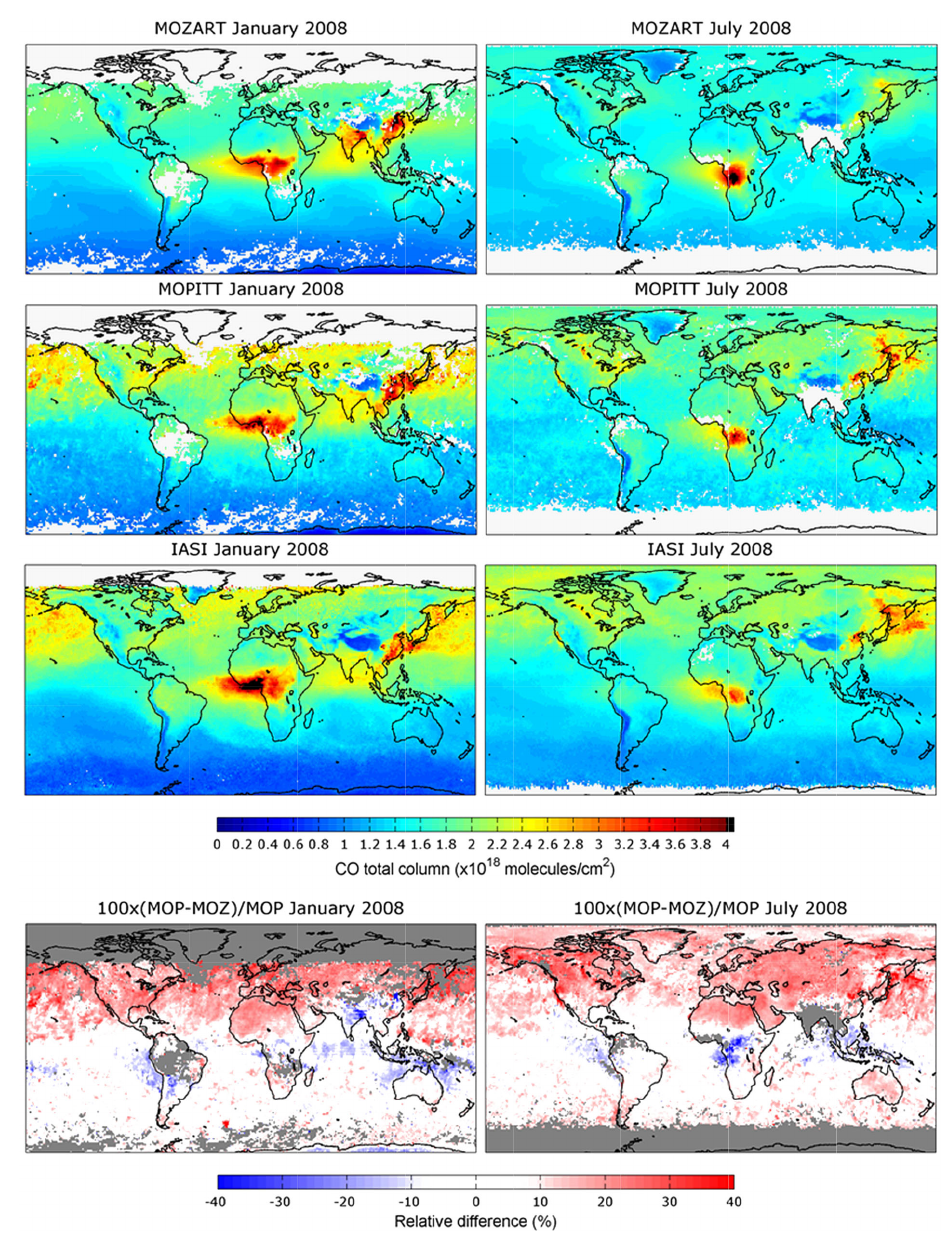
Figure 5. Monthly mean CO total column densities for January and July 2008 as observed from IASI and MOPITT, and calculated from simulation MI smoothed by MOPITT averaging kernels. The relative difference between the model simulations and MOPITT observations (100 × (MOPITT − MOZART)/MOPITT) is seen in the bottom